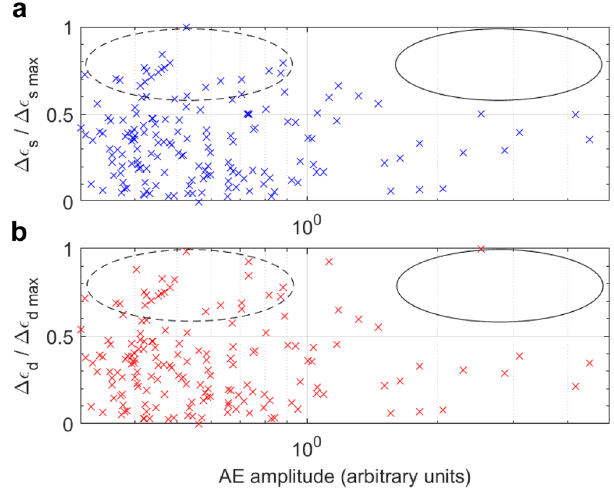
Fig. 5 | Relationship between acoustic emission (AE) amplitude (in log-scale) and local incremental strain at the AE location. a Incremental shear strain, Δ ϵ s (blue crosses), and b incremental dilation, Δ ϵ d (red crosses), each normalised by their respective maximum. The solid black ellipses highlight the lack of large AE events at locations of large strain; indicative of predominantly aseismic deforma- tion. Conversely, thedashed black ellipses highlight locations of large strainwhich are connected to mostly smaller AEevents. LargerAEevents aremostlyassociated with smaller